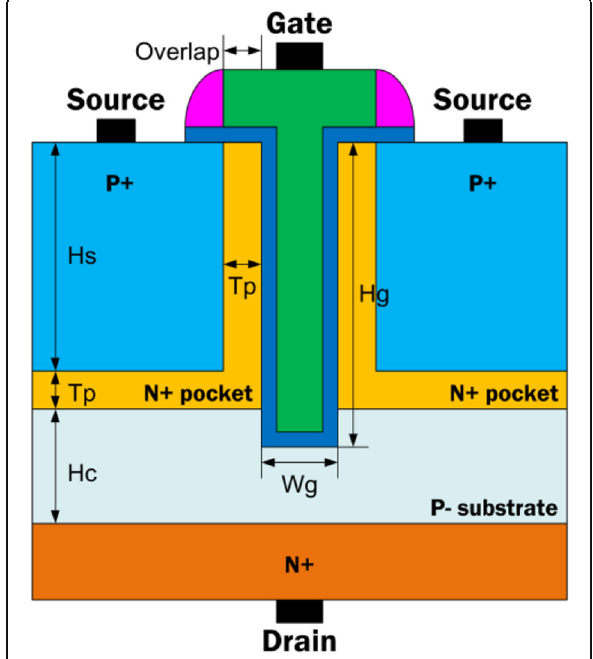
Fig. 1 Schematic of the proposed T-shape gate dual-source tunnel field-effect transistor